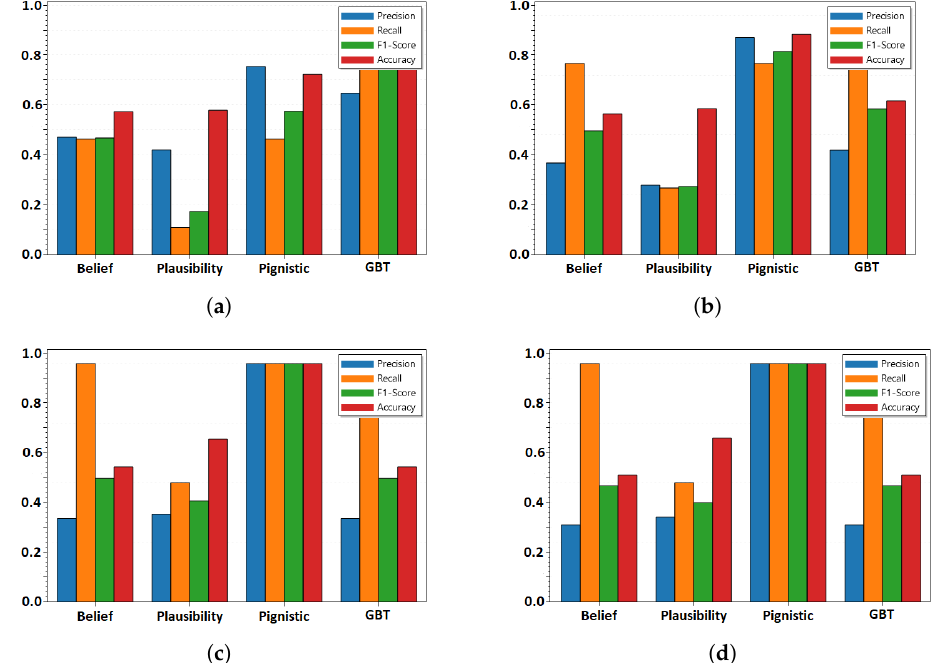
Figure 8. Precision, recall, F1 score, and accuracy obtained based on the different decision criteria from disjunctive-based DS fusion by location from probability scores of Decision Tree classifiers with combined cyber-physical features and different time resolutions ( a ) res = 5 s; ( b ) res = 10 s; ( c ) res = 15 s; ( d ) res = 20 s.